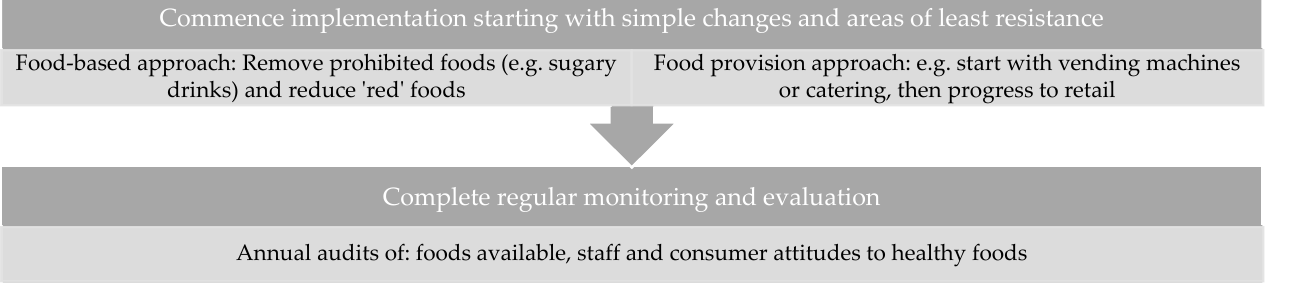
Figure 3. Recommended steps to implementing the guidelines determined through the synthesis and analysis of interviews.